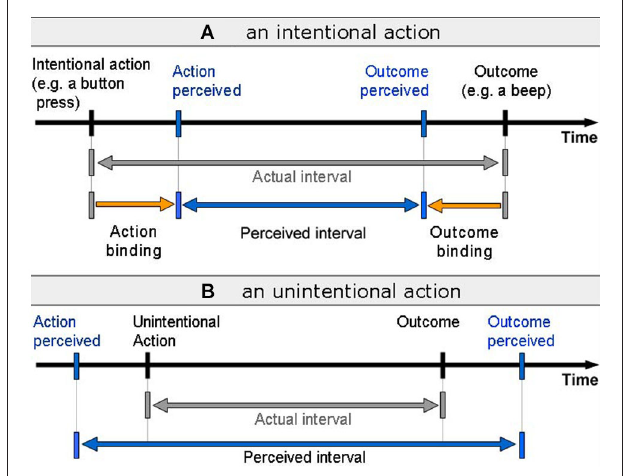
FIGURE 1 | Intentional Binding. (A) During voluntary action, the perceived time of action and outcome are shifted toward one another, resulting in a shorter perceived interval between action and outcome. (B) During involuntary actions, the perceived time interval between action and outcome is longer than the actual